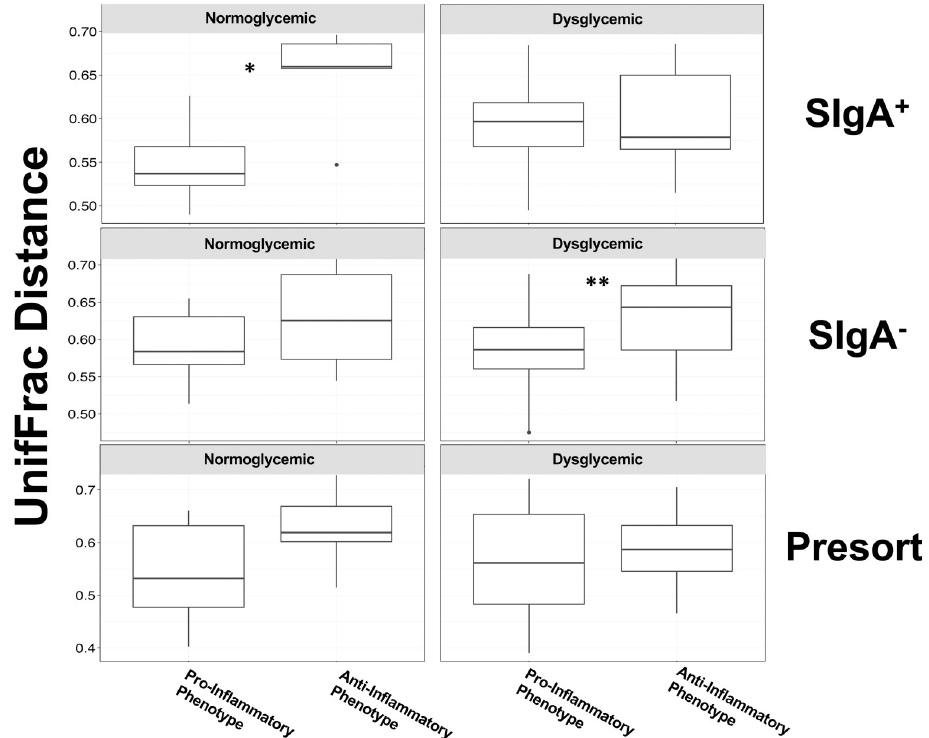
Fig 8. Comparisons of UniFrac distances between of the stool IgA-Biome of normal and dysglycemic individuals categorized by inflammatory phenotype. Box plots compare unweighted UniFrac distances between all individuals within each inflammatory phenotype, respectively, by SIgA compartment and glycemic profile. Normoglycemic subjects with a pro-inflammatory phenotype have SIgA + bacterial community compositions more similar to each other than do those with an anti-inflammatory phenotype ( � p < 0.0152). Similarly, dysglycemic subjects with a pro- inflammatory phenotype have SIgA - bacterial community compositions more similar to each other than do those with an anti-inflammatory phenotype ( �� p < 0.023). P-values determined using the Mann-Whitney U-test.